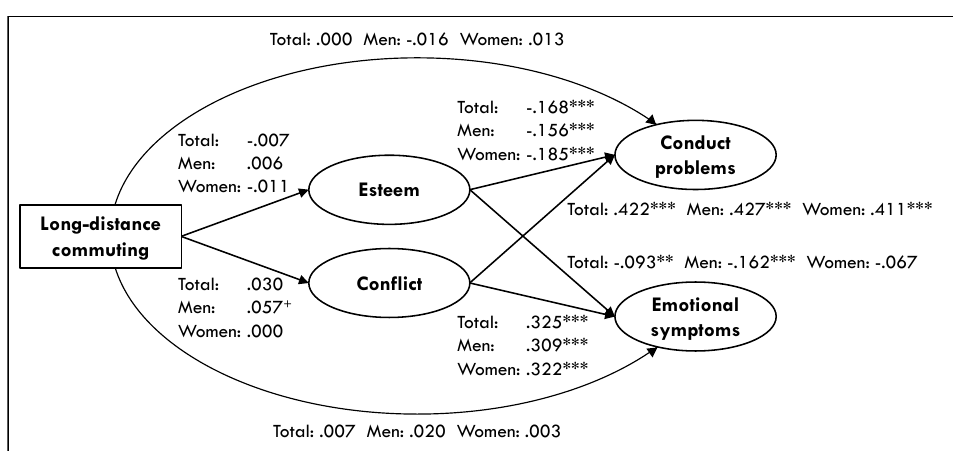
Figure 3 : The association between parents’ long-distance commuting, parent-child relationship and child well-being (evaluated by the